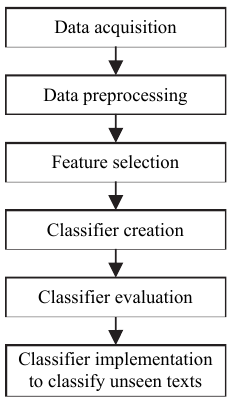
Fig.1. The sub-tasks required to perform the sentiment analysis on given